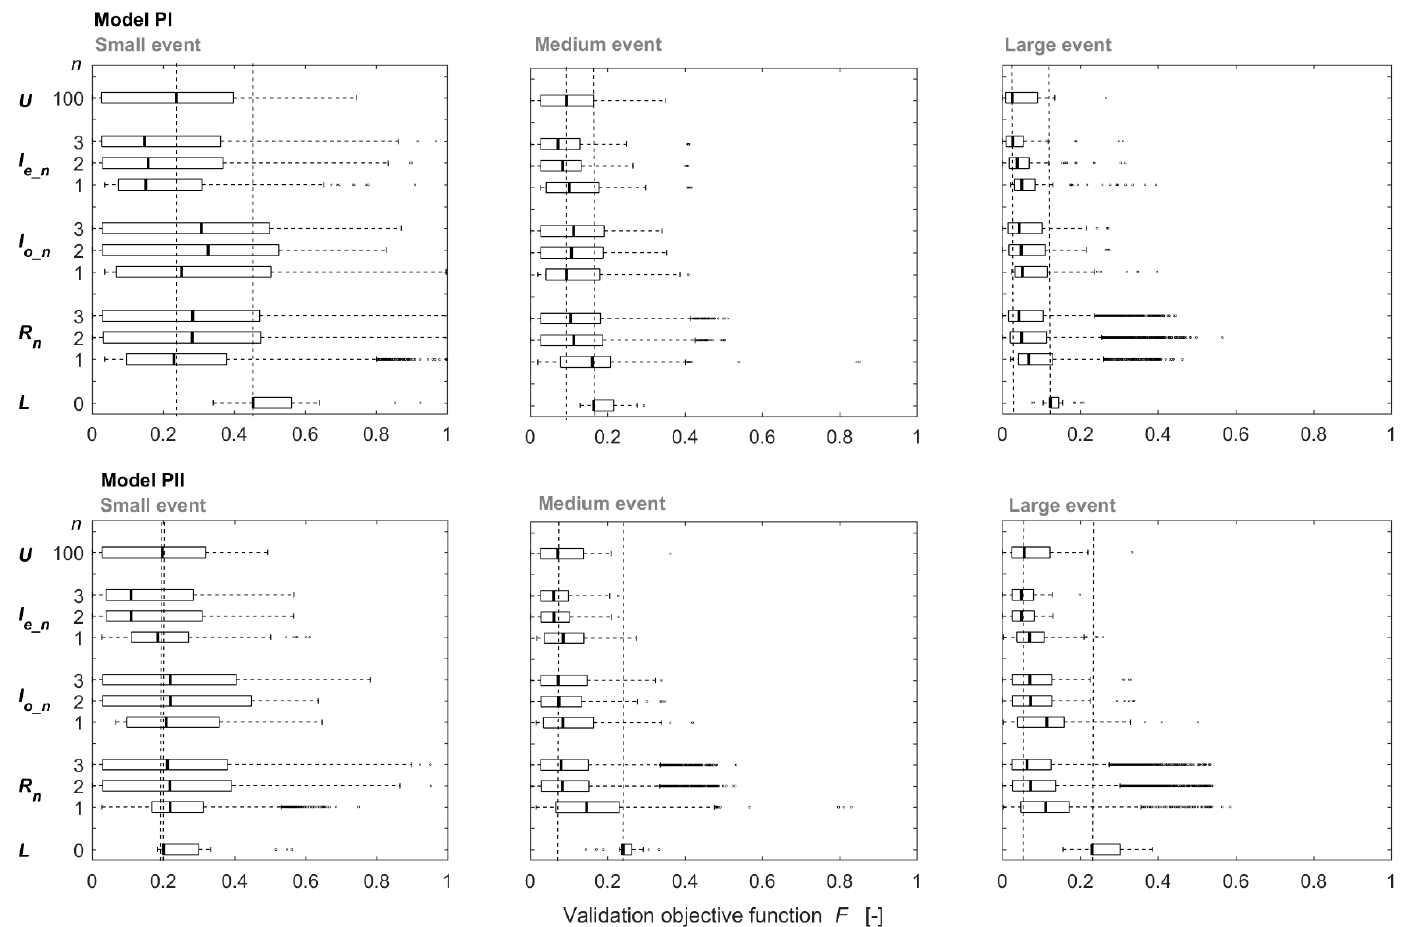
Figure 9. Comparison of the value of the objective function ( F ) for the validation performance for different sampling strategies, including the lower benchmark ( L ), a random selection ( R n ), two intelligent selections ( I 0_n and I e_n ) and the upper benchmark ( U ), with 1, 2 or 3 samples ( n = 1, 2, 3). The two dotted vertical lines show the median value of the validation objective function ( F ) for the lower and upper benchmarks.